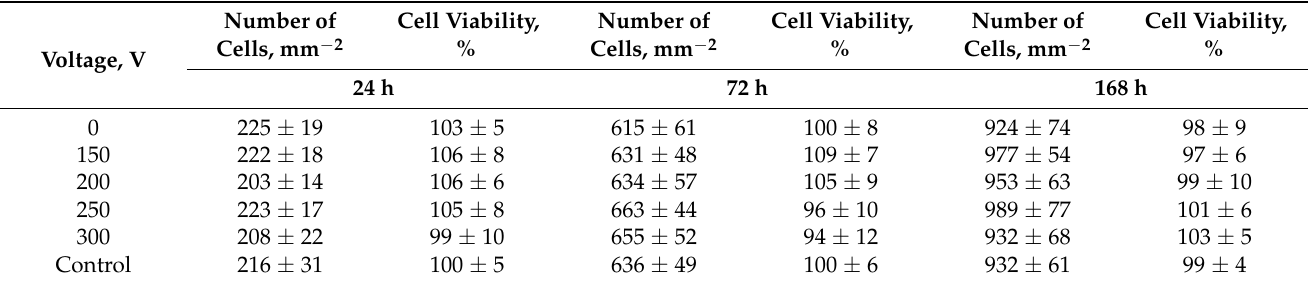
Table 4. Results of testing the cytotoxicity of obtained membranes after 24, 72, and 168 h of cultiva- tion.